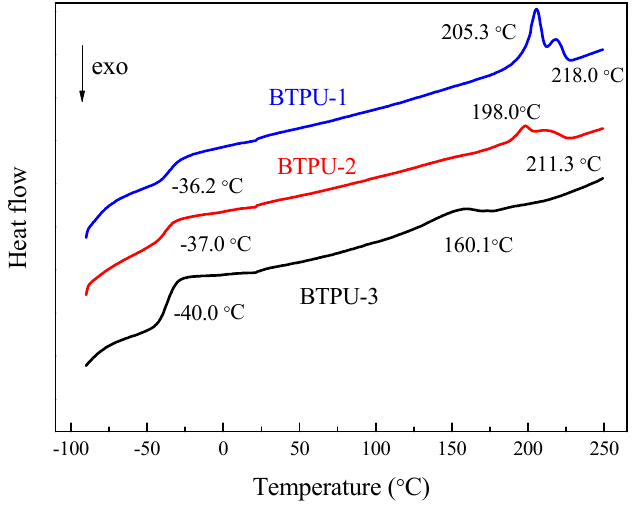
Figure 6. Thermal properties of BTPU with different BPD contents.